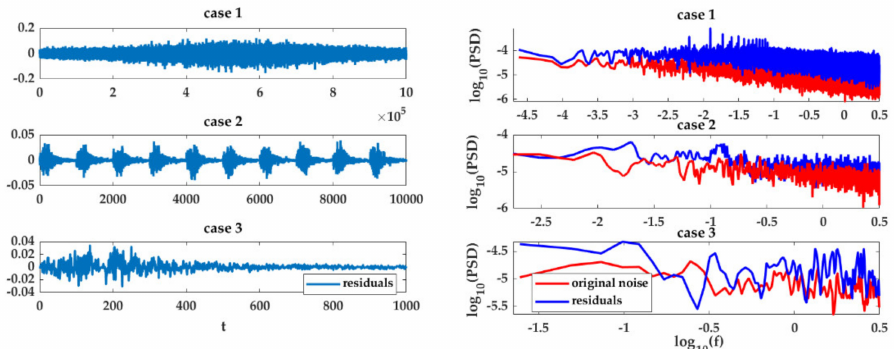
Figure 5. ( left ): Residuals of the plane adjustment versus time (top: case 1, the whole residuals, middle: case 2, the first 10,000 values, bottom: case 3 the first 1000 values corresponding to one scanning line). The x-axis corresponds to the time, exemplarily in (s), whereas the y-axis is the residuals, exemplarily in (m). ( right ): The corresponding PSD as a log–log plot. F is given in Hz and the PSD in dB / Hz. No additional angle